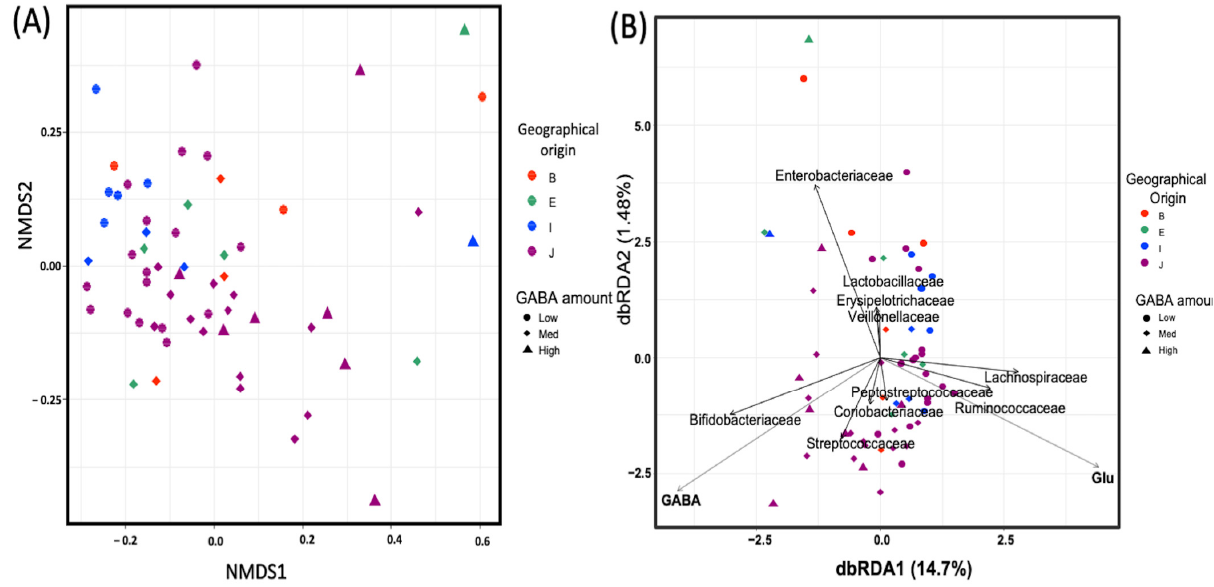
Figure 3. Beta diversity and community similarity analysis among fecal gamma-aminobutyric acid (GABA) groups. ( A ) Non-metric multidimensional scaling (NMDS) plot based on the distance matrix of operational taxonomic units (OTUs) designated at the family level of taxonomic classification calculated using the Bray–Curtis model. ( B ) Distance-based redundancy analysis (db-RDA) using the Bray–Curtis dissimilarity matrix calculated with OTUs designated at the family level of taxonomy. The environmental variables were statistically significant ( p < 0.01), and the top 10 most abundant taxa are displayed. Circle, diamond, and triangle symbols represent participants categorized as low-, medium-, and high-GABA productivity groups, respectively. Different colors represent the geographical origin of each participant: B, South Asia; E, Northeast Africa; I, Southeast Asia; J, East